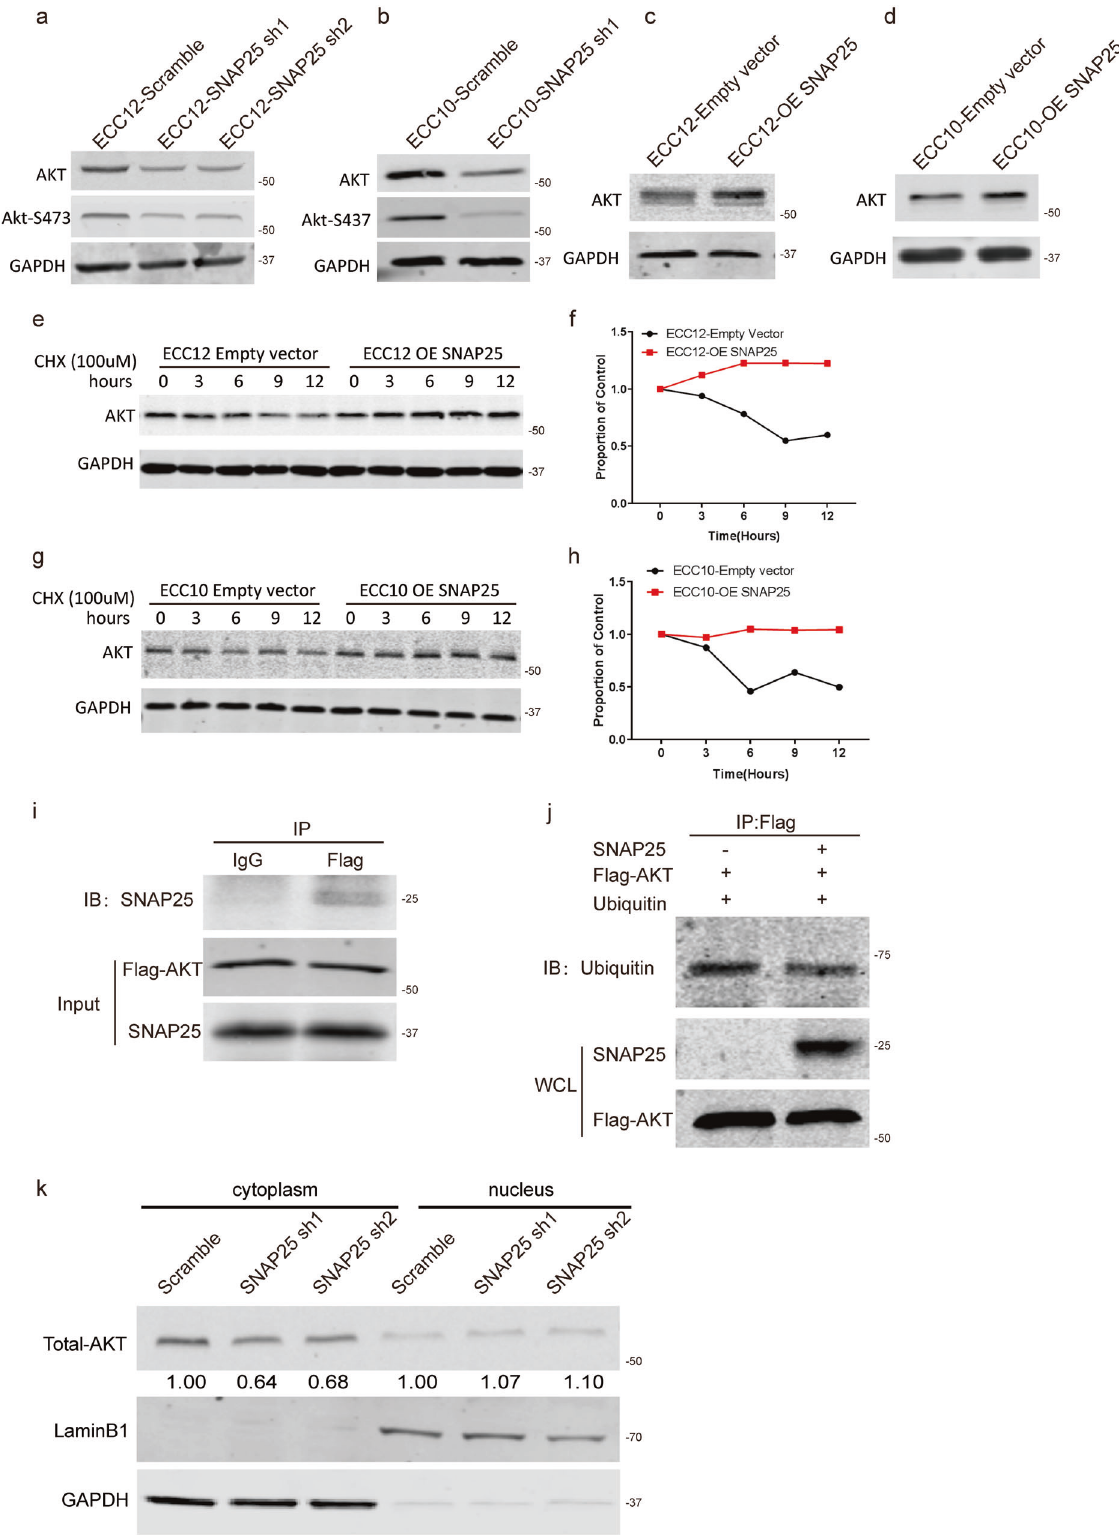
Fig. 5 AKT protein stability is mediated by SNAP25 via a direct binding effect. a – d Changes in AKT protein levels were mediated by SNAP25 knockdown and overexpression in GNEC cell lines. e – h The half-life of AKT protein was mediated by SNAP25 overexpression in GNEC cells. i The binding effect between SNAP25 and AKT. j The AKT ubiquitination status was changed with or without SNAP25 expression. k The AKT protein level in the cytoplasm was changed upon SNAP25 disruption.